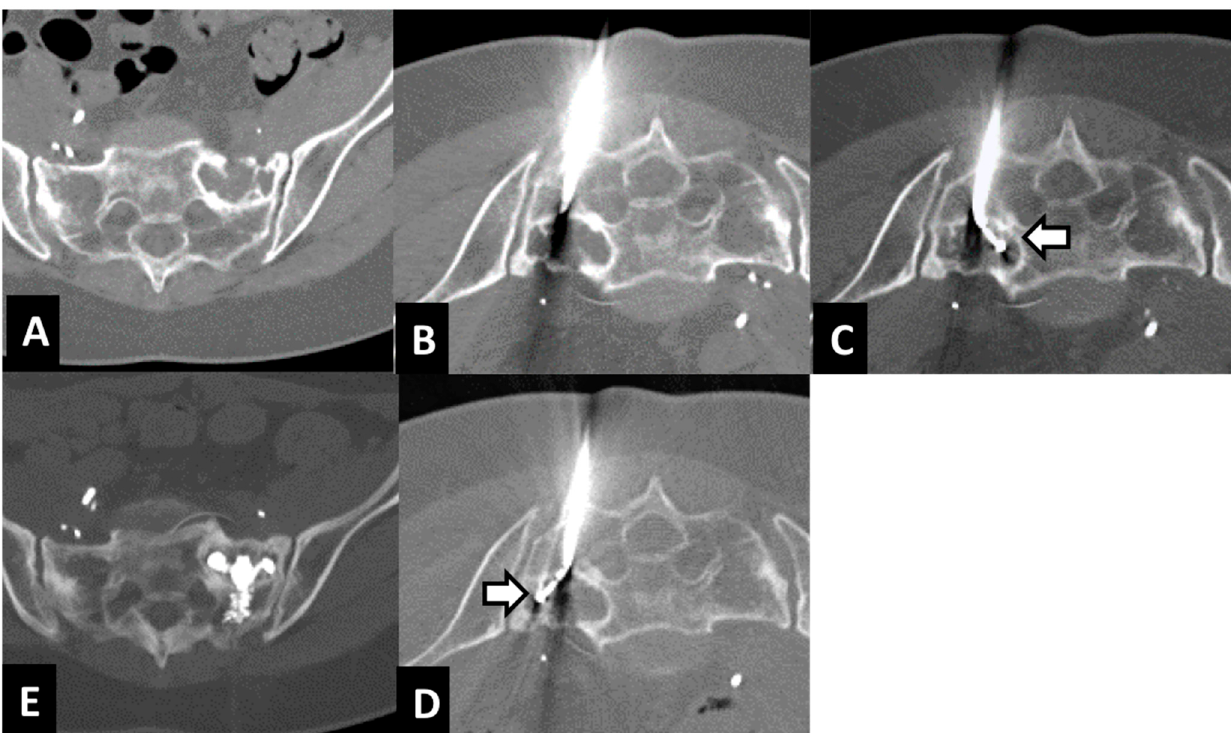
Figure 3. Treatment with tRFA and osteoplasty of a sacral metastasis from breast cancer in a 62-year-old woman. Axial CT scan showed a 37 mm lytic metastasis of the left sacral ala ( A ). The metastasis was reached with a 10-gauge Stabilit cannula ( B ). Axial CT showed two different placements of the steerable radiofrequency bipolar device (tSTAR) covering the entire lesion (arrows) ( C , D ). Axial CT scan showed the metastasis filled by PMMA ( E ).